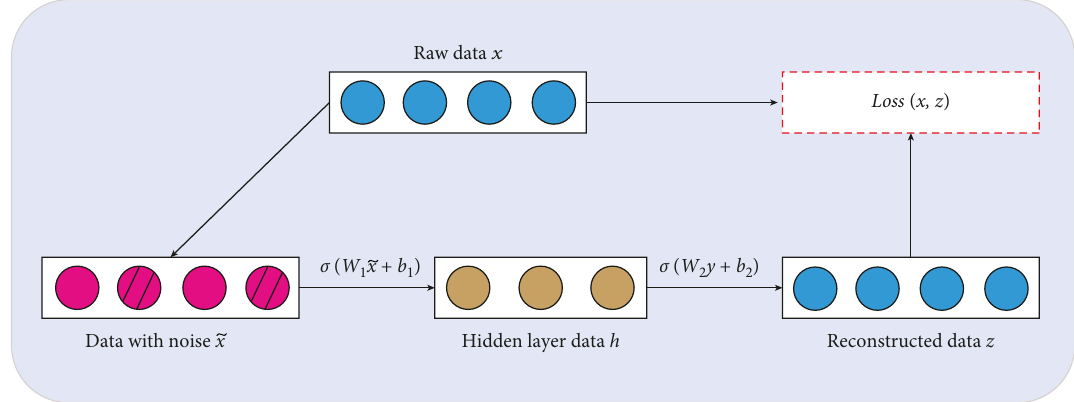
Figure 4: Denoising autoencoder (DAE) network